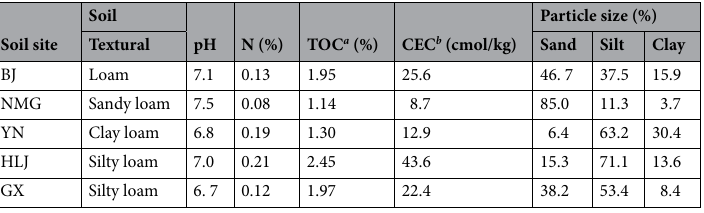
Table 1. Properties of tested soils. TOC a = total organic carbon content. CEC b = cation-exchange